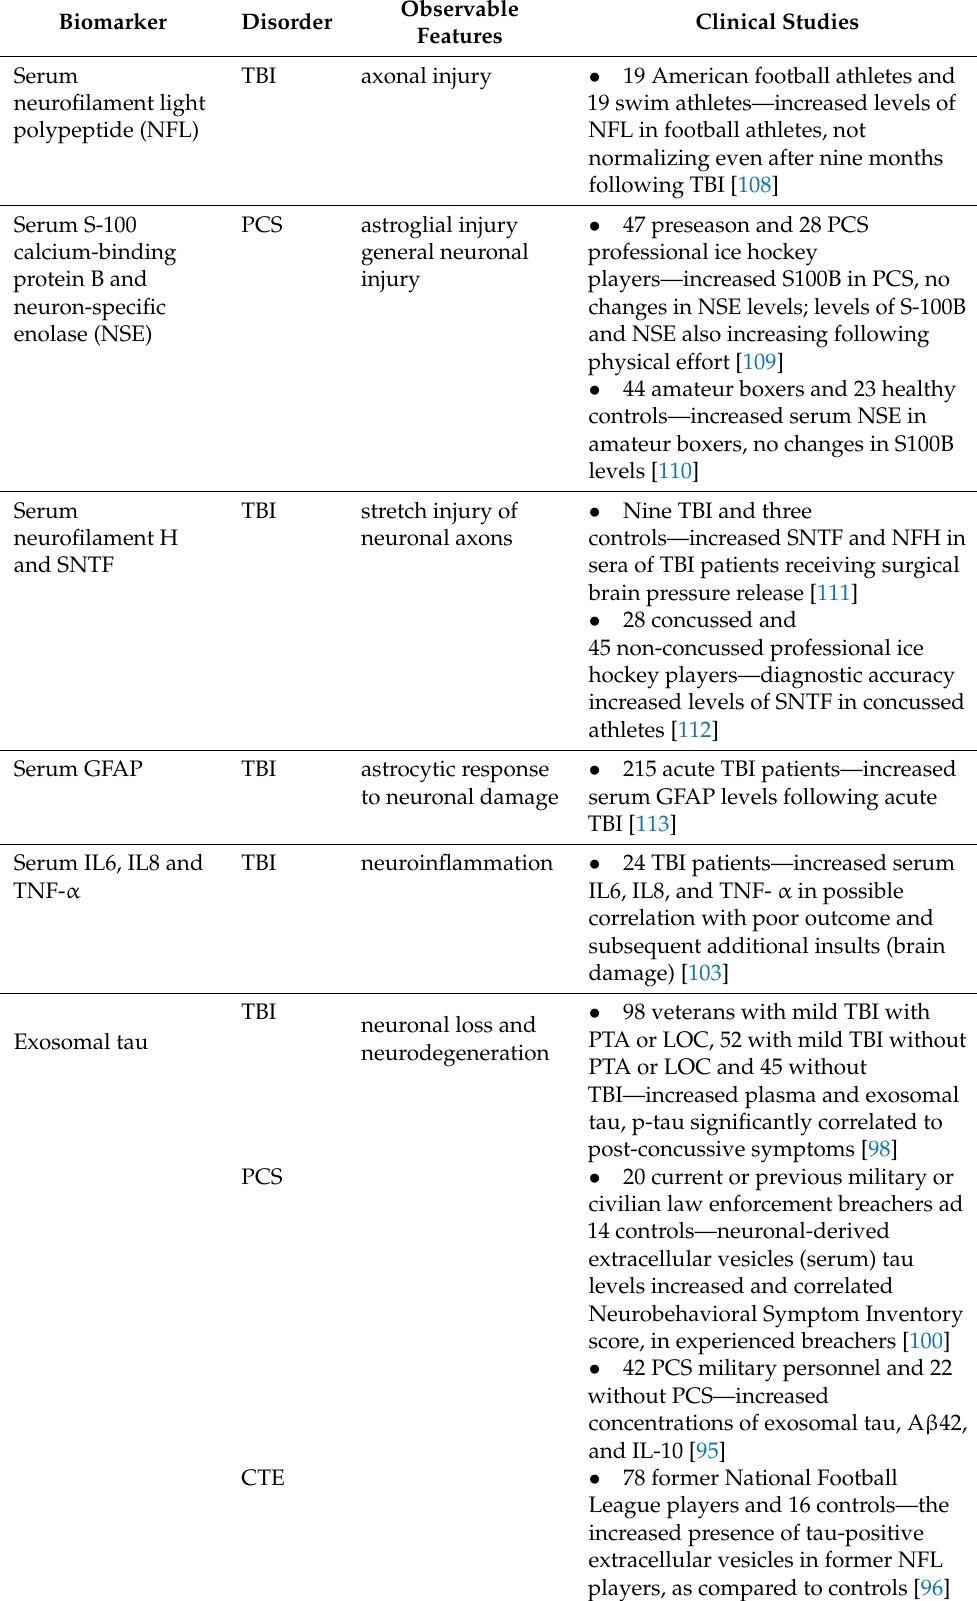
Table 3. Fluid biomarkers for traumatic brain injury following repeated head